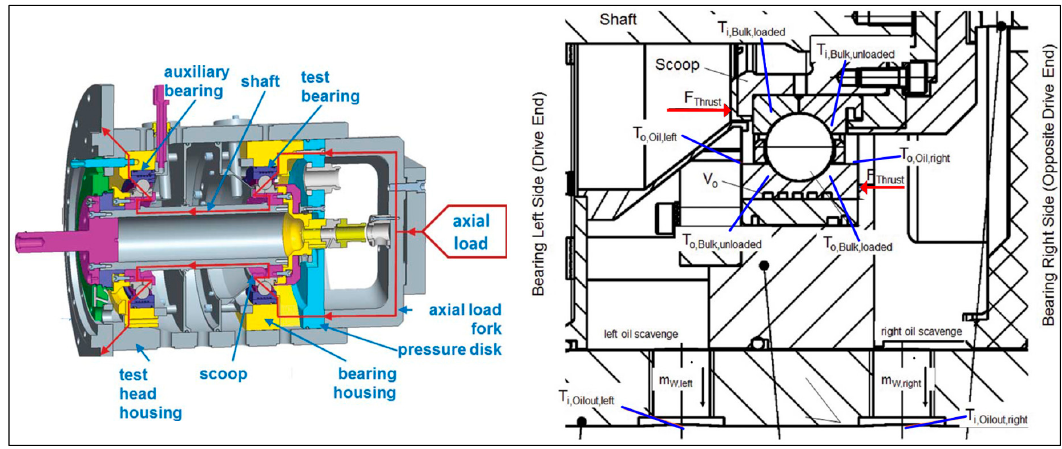
Figure 4. Cross section of the test facility at FAG Aerospace [1].